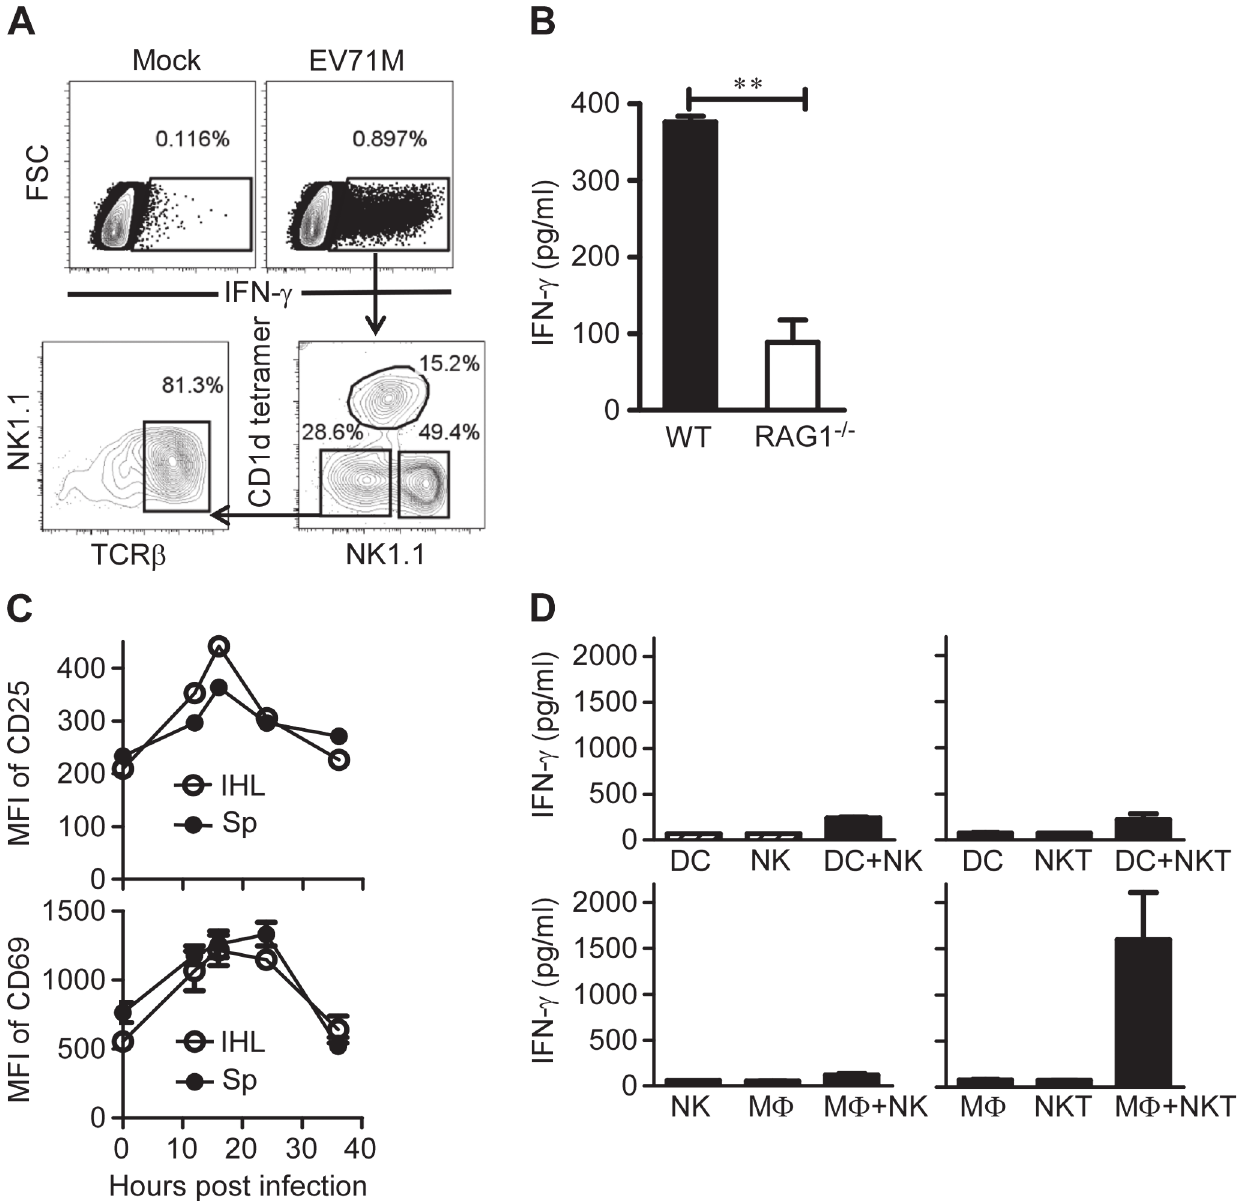
Figure 2. EV71 infection activates iNKT cells through triggering macrophages. (A) Increase of IFN- γ -producing cells among splenocytes after EV71M infection. Splenocytes from 6 – 8-week-old C57BL/6 mice (n = 3) were infected with 10 MOIs of EV71M for 18 hours and then stained with TCR β , CD1d tetramer, NK1.1 and IFN- γ . CD1d-tetramer, TCR β versus NK1.1 profiles are shown for IFN- γ -positive cells. (B) Splenocytes from RAG1-knockout (RAG1 -/- ) mice upon EV71M infection produced little IFN- γ . Splenocytes from WT (n = 3) and RAG1 -/- (n = 3) mice were cultured in the presence of EV71M for 24 hours. The supernatants were examined for IFN- γ with an ELISA assay. (C) The CD69 and CD25 expression levels of iNKT cells in the spleens (Sp) and intrahepatic leukocytes (IHL) of EV71M-infected mice (n = 3). Splenocytes of control (PBS) or EV71M-infected C57BL/6 mice were stained with TCR β , CD1d tetramer, CD69 or CD25 and DAPI. (D) EV71M-infected macrophages, but not DCs, induced IFN- γ production by iNKT cells. Purified DCs and macrophages were cultured with EV71M for 24 hours and then co-cultured with purified NK or iNKT cells for a further 18 hours. Cytokine concentrations were determined by ELISA. Data are represented of five (A), three (mean ± SD in D) or two (B, C) independent experiments.